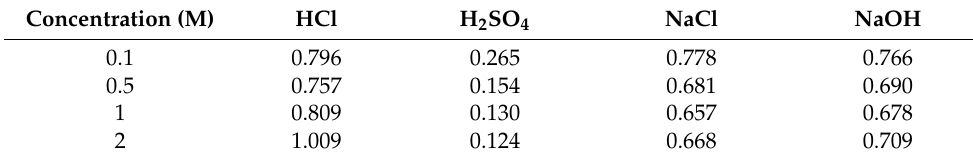
Table 3. Activity coefficients for various chemical